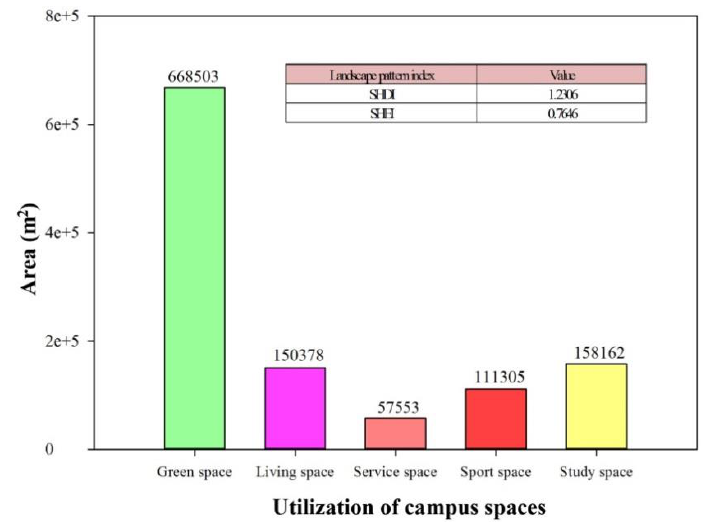
Figure 10. Utilization of campus spaces.